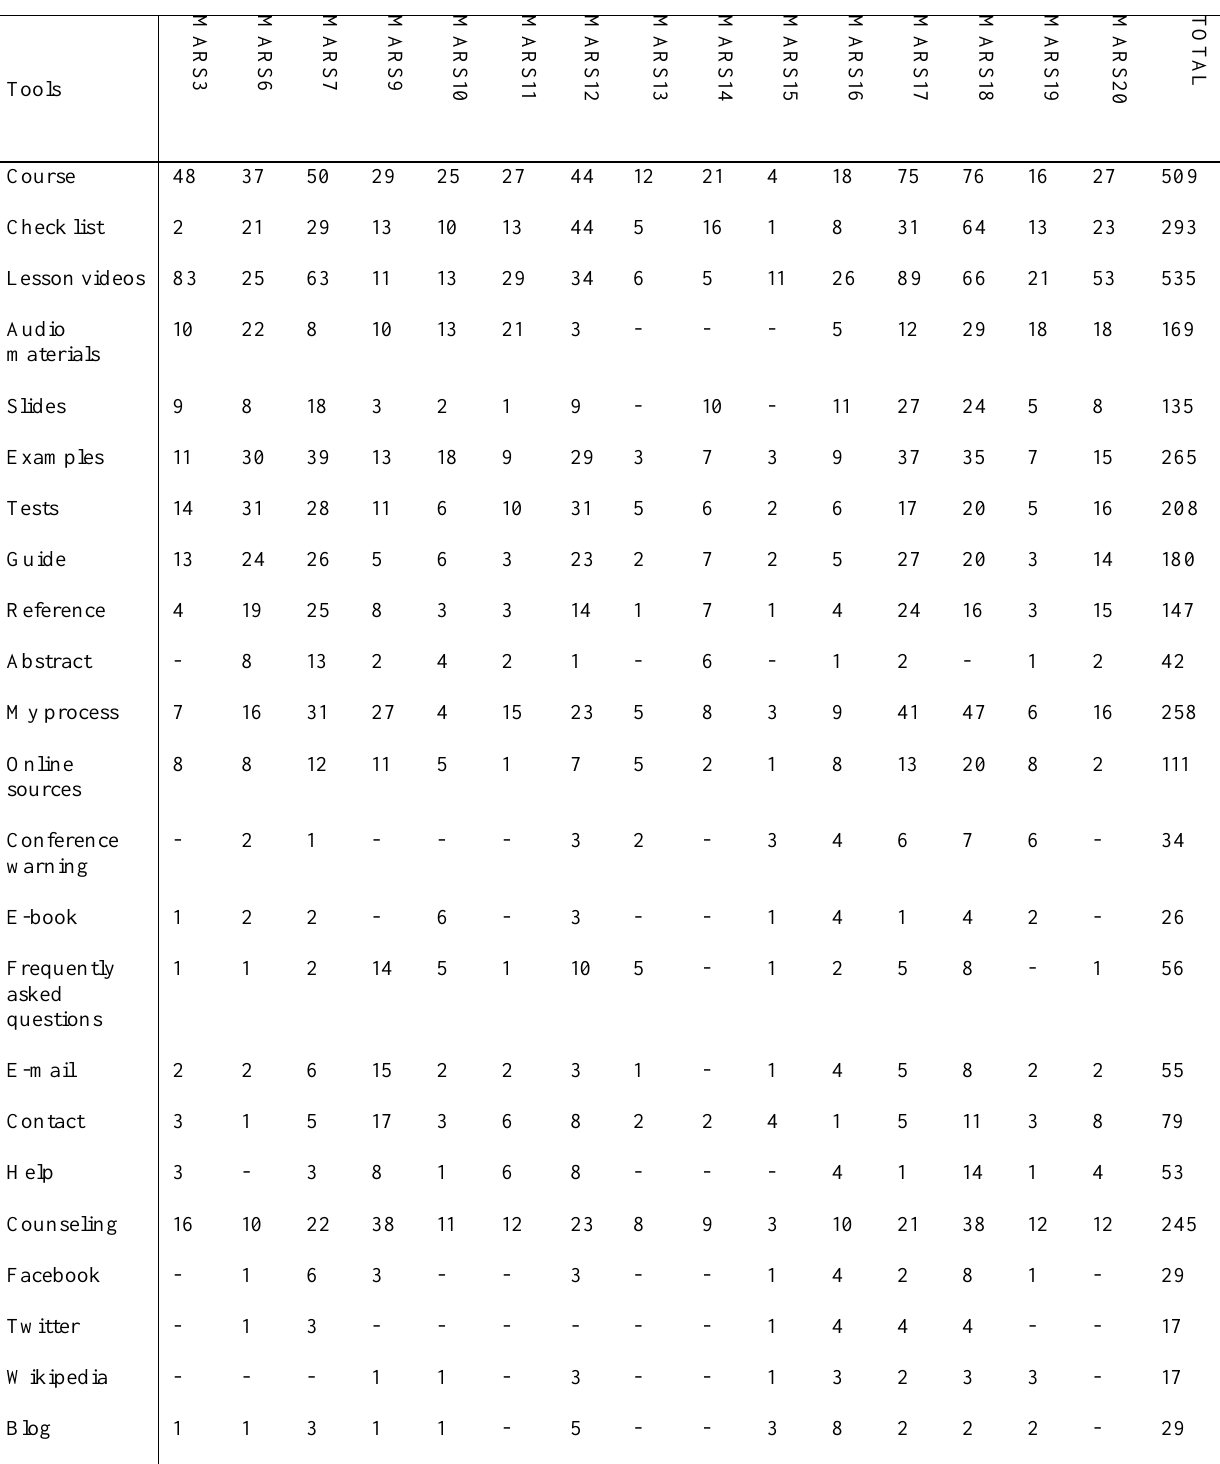
Table 6 Weekly Frequency of Participants’ Use of the M-learning System Tools